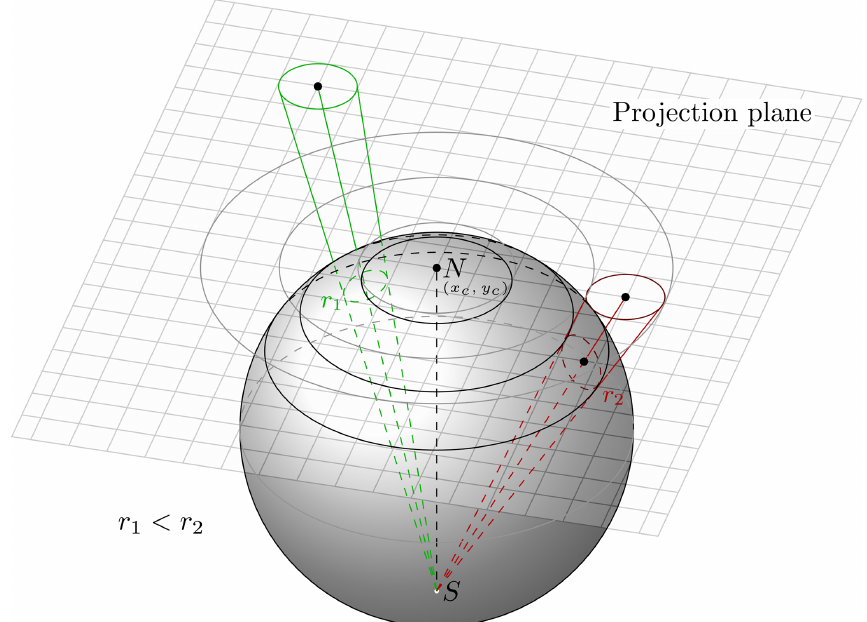
Figure 3. Depiction of the stereographic projection used in our identification strategy. This figure shows that circles on the sphere are mapped to circles on the projection plane. Therefore, this projection is conformal, a vital property for this strategy. Note that despite having the same shape, the sizes of the circles on the sphere vary by distance from the projection